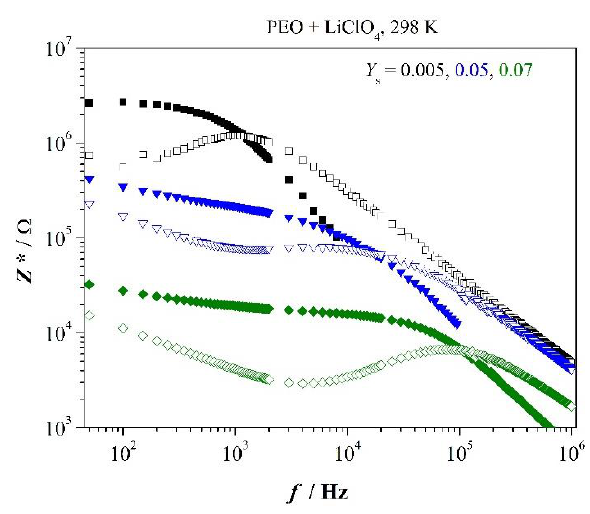
Figure 2. Impedance spectra of PEO with indicated salt concentration; Z” – open marker.